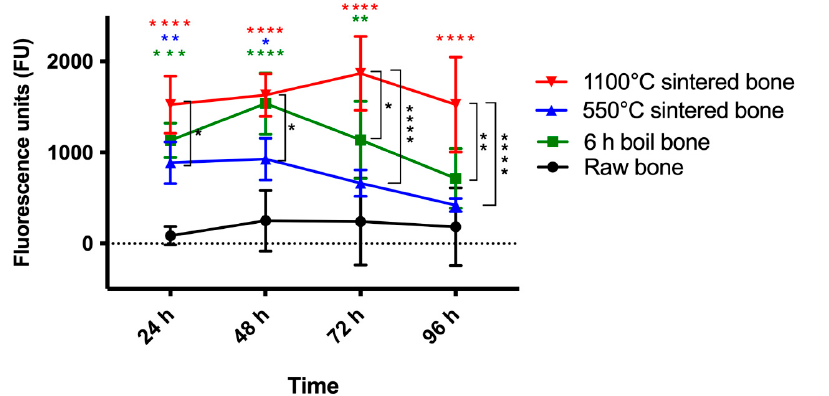
Figure 6. Human calvarial osteoblast (HCO) cells seeded on different treated bones assessed with PrestoBlue™ proliferation assay ( n = 4, mean ± SD). * p -value ≤ 0.05, ** p -value ≤ 0.005, *** p -value ≤ 0.0005, **** p -value ≤ 0.0001 compared to Group 1 (raw bone) mean.